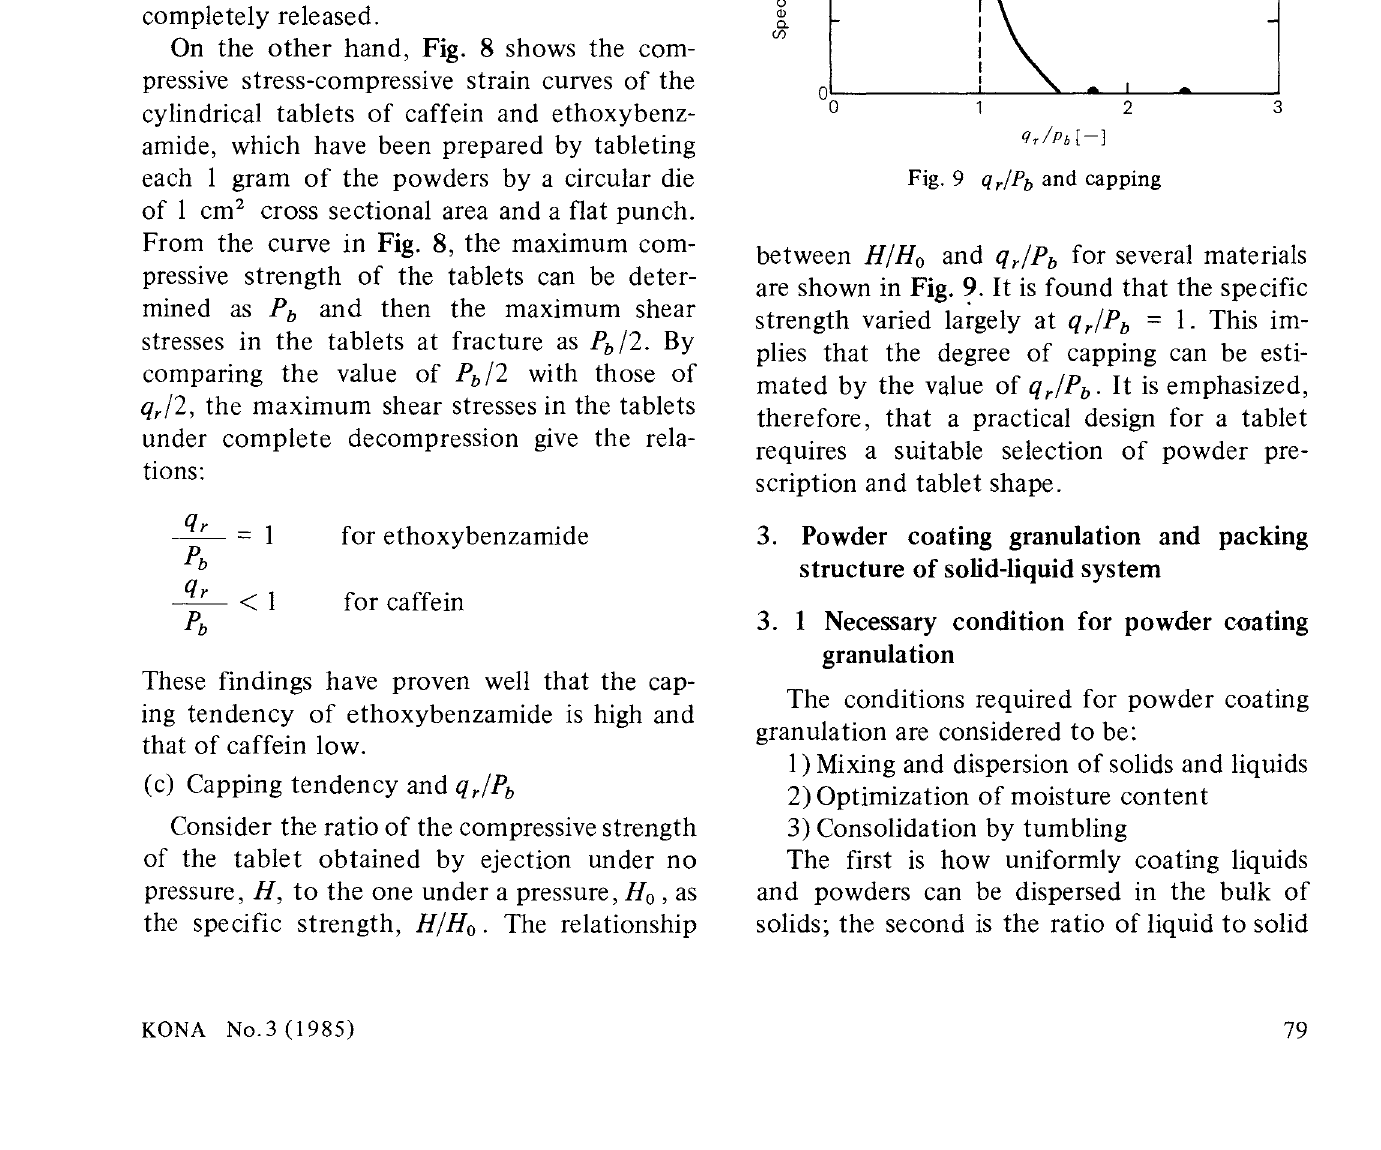
Fig. 7 Maximum shear stress in compact during decompression